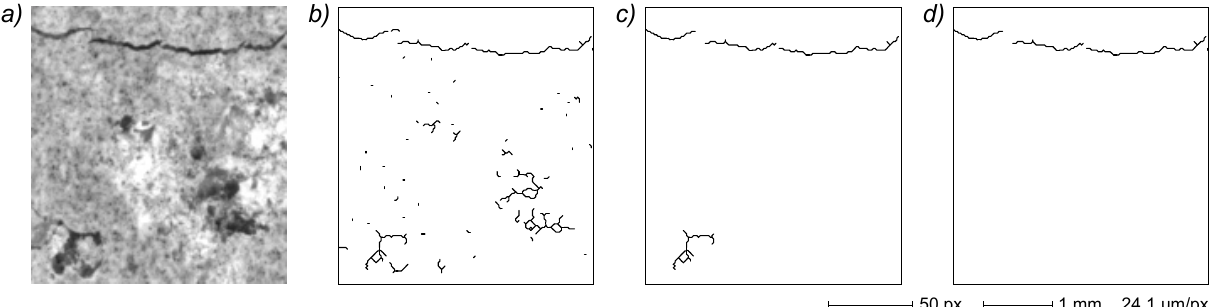
Figure 7. Noise removal with EG processing. Surface texture ( a ) generates a substantial number of noise artefacts in primal EG ( b ) that is mostly removed by the first noise removal step ( c ). The remaining artefact (bottom left) is eliminated in the following sugraph filtration step ( d ).